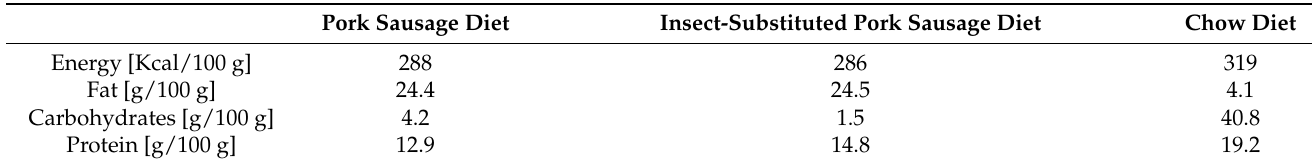
Table 1. Nutrient content of experimental